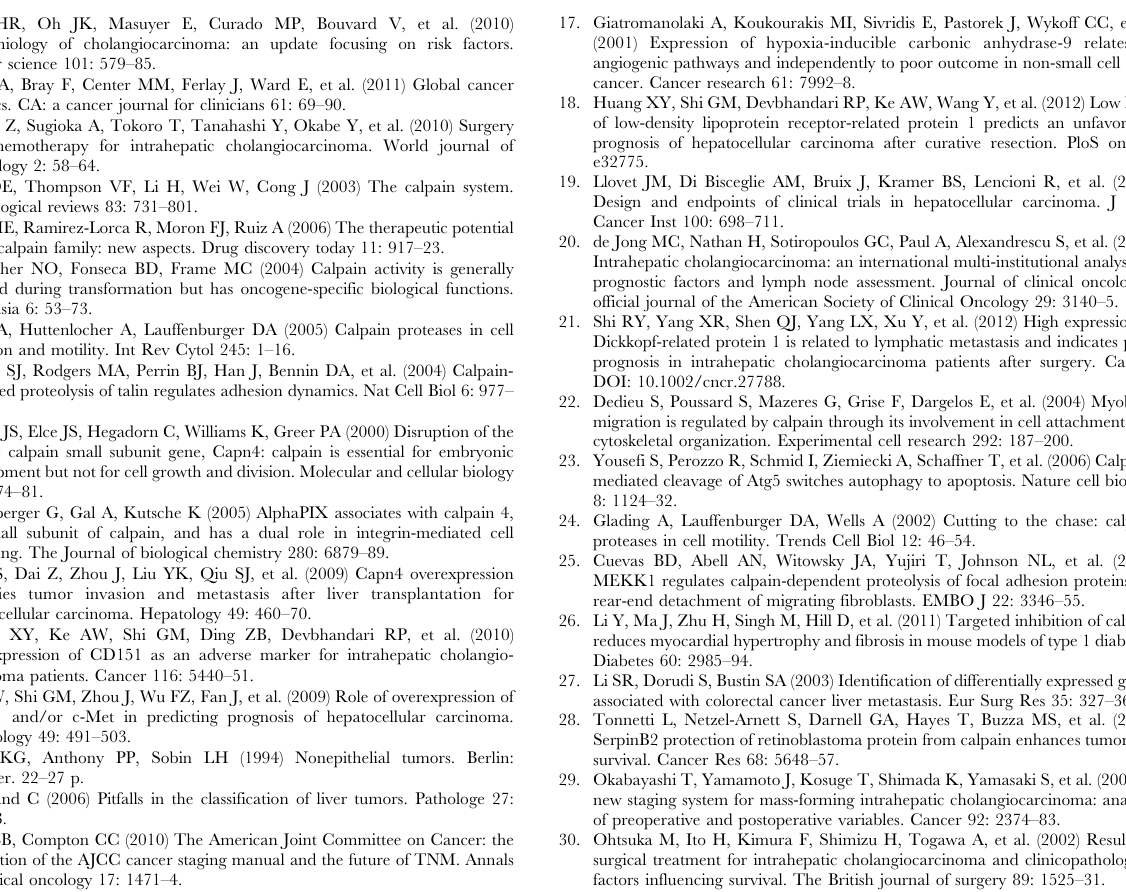
Table S1 Correlations between Capn4 and clinicopath- ological features in 138 ICC patients. Table S2 Univariate and multivariate analysis of fac- tors associated with survival and recurrence in 138 ICC